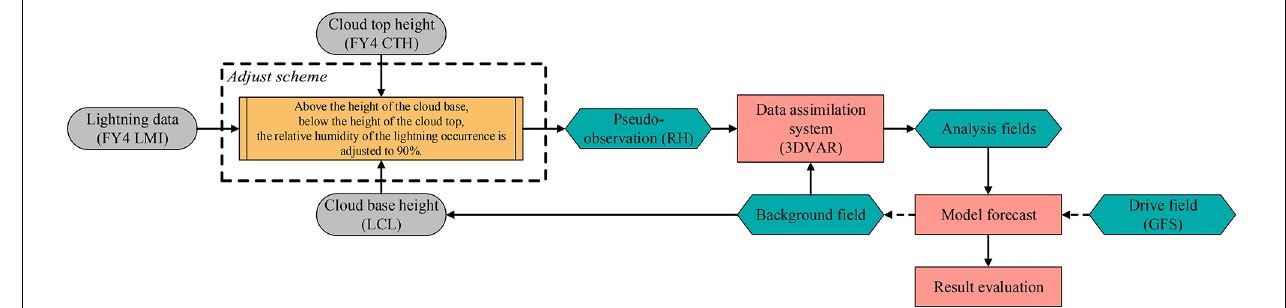
FIGURE 3 | Flow chart for the lightning data assimilation (LDA) procedure.